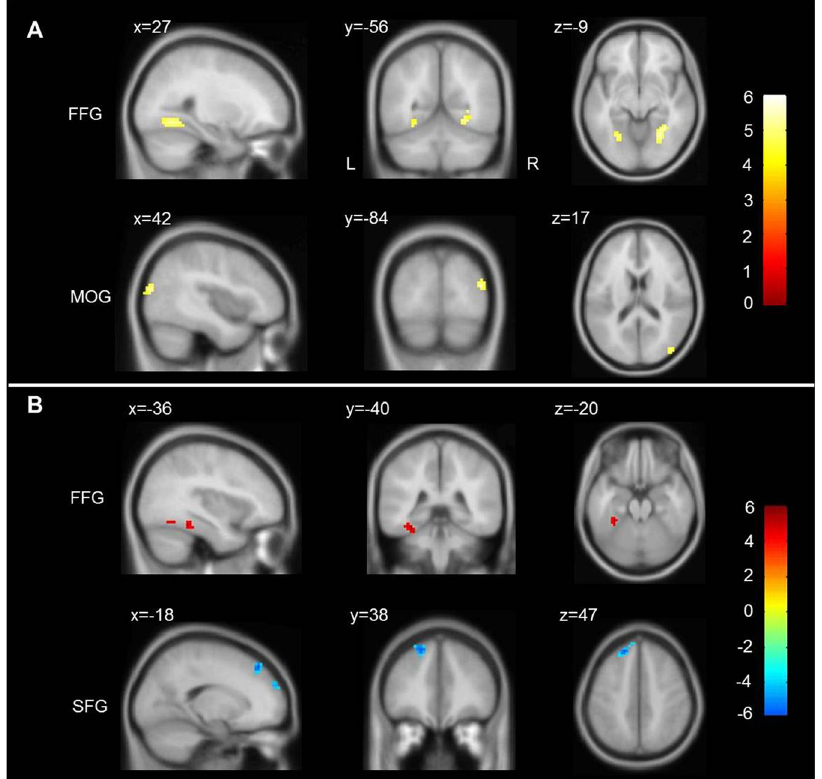
corrected (i.e., p-voxel < 0.0005 with minimum cluster size = 22 voxels). Color bar denotes t value. x, y, z denote MNI (Montreal Neurological Institute) coordinates. IFG = inferior frontal gyrus, FFG = fusiform gyrus, MOG = middle occipital gyrus, SFG = superior frontal gyrus, GAD = generalized anxiety disorder, HCs = healthy controls, L = left, and R =